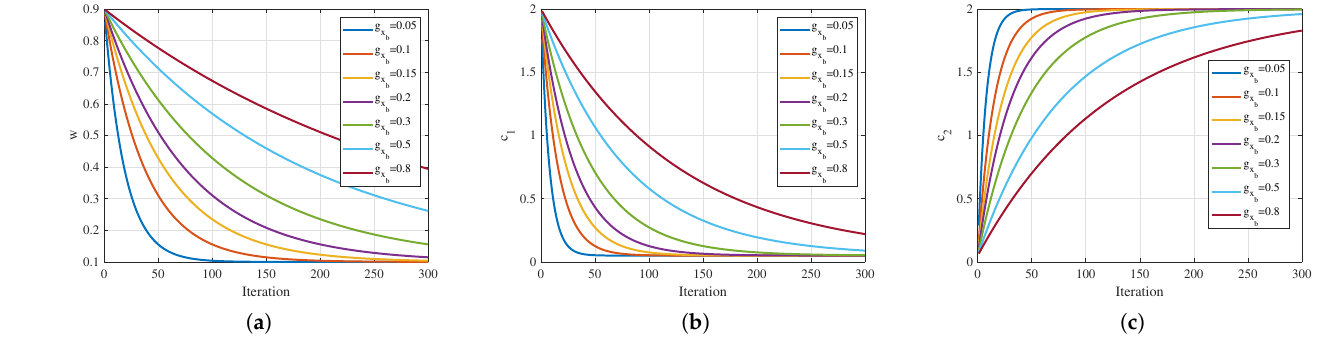
Figure 3. Variation curves of the three control parameters with different g x and ( c ) c 2